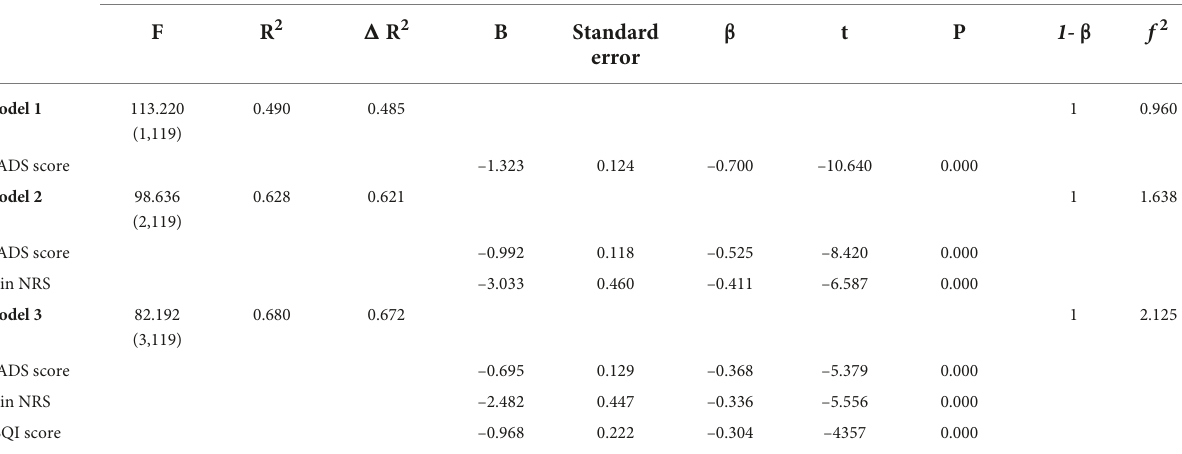
TABLE 2 Linear regression analysis (Dependent variable: SF-36; Predictors: Pain NRS, PSQI score, HADS score). Model summary and coefficients of the significant